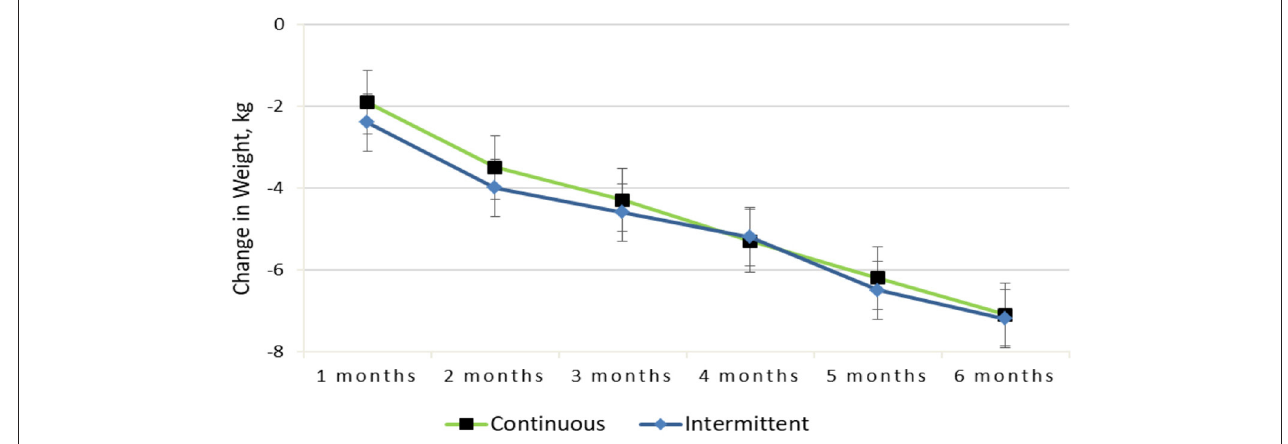
FIGURE 2 | Change in weight from baseline to 6-months for the continuous vs. intermittent groups (completer analysis).